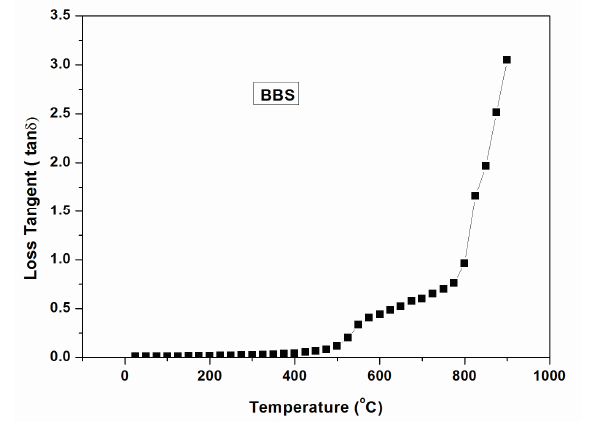
Figure 9. Dielectric loss tangent (with temperature ~1000 °C) of barium borosilicate